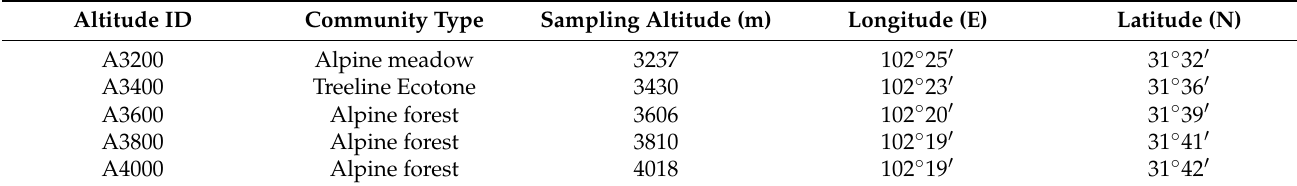
Table 1. Basic information on sampling